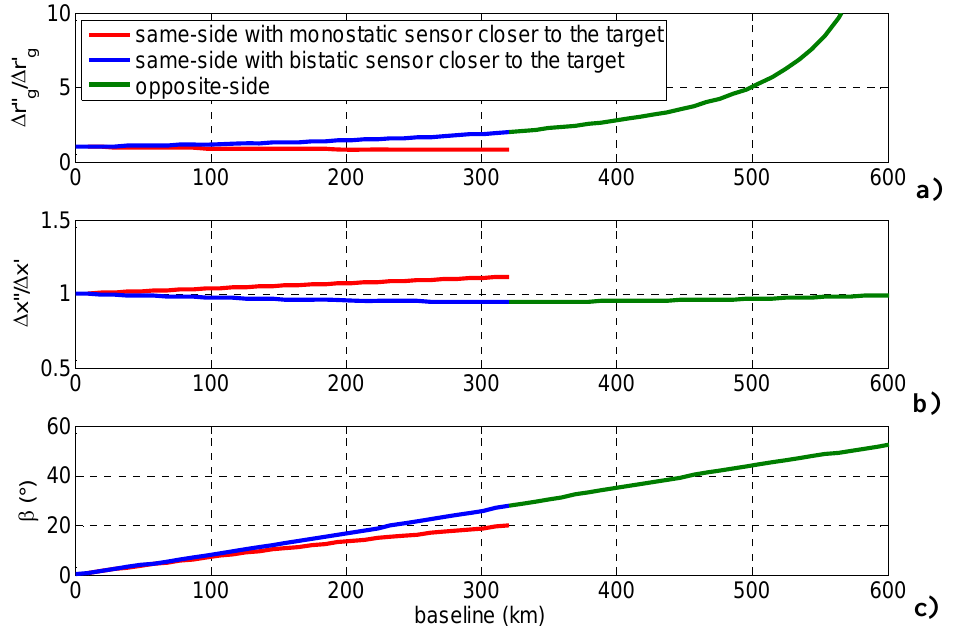
Figure 2. (a) Bistatic-to-monostatic ground range resolution ratio, (b) bistatic-to-monostatic azimuth resolution ratio, (c) bistatic angle, as a function of baseline (platforms operating at